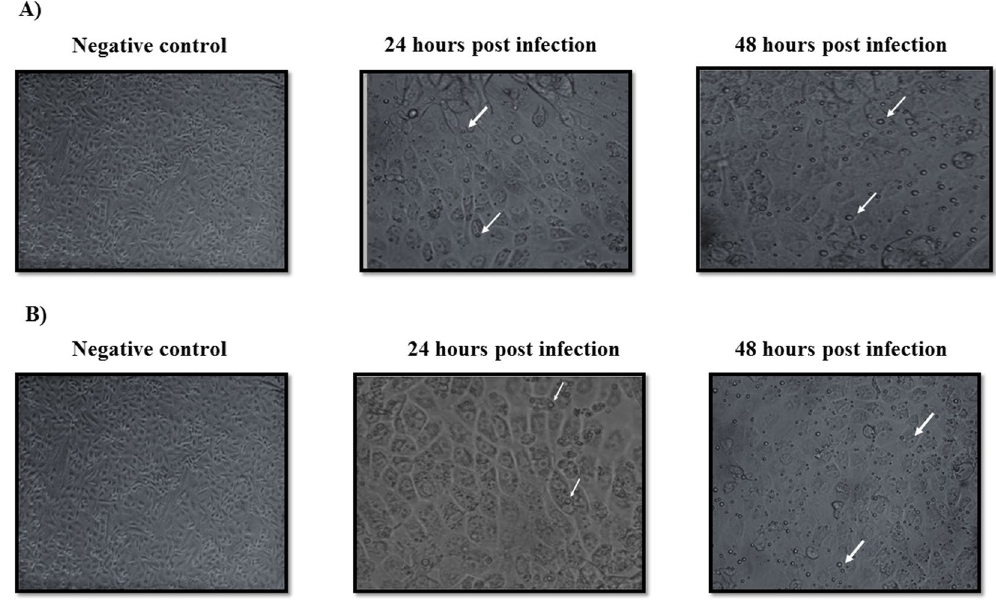
Figure 4. Ability of the cagA + vacA s1a m1 i1 strain to induce vacuolization of vero cells. Broth culture filtrate of H . pylori test strains ( A ) fecal cow isolate before experimental inoculation in pasteurized milk and ( B ) the strain isolated from the experimentally infected mice were added to vero cells and incubated for 24 and 48 hours at 35 °C in the presence of CO 2 . Un-inoculated brucella broth was used as a negative control. Intracellular vacuolization (pointed out with white arrows) was read under inverted microscope with 400x magnification. The densities of the cells shown are 5.5 × 10 6 .